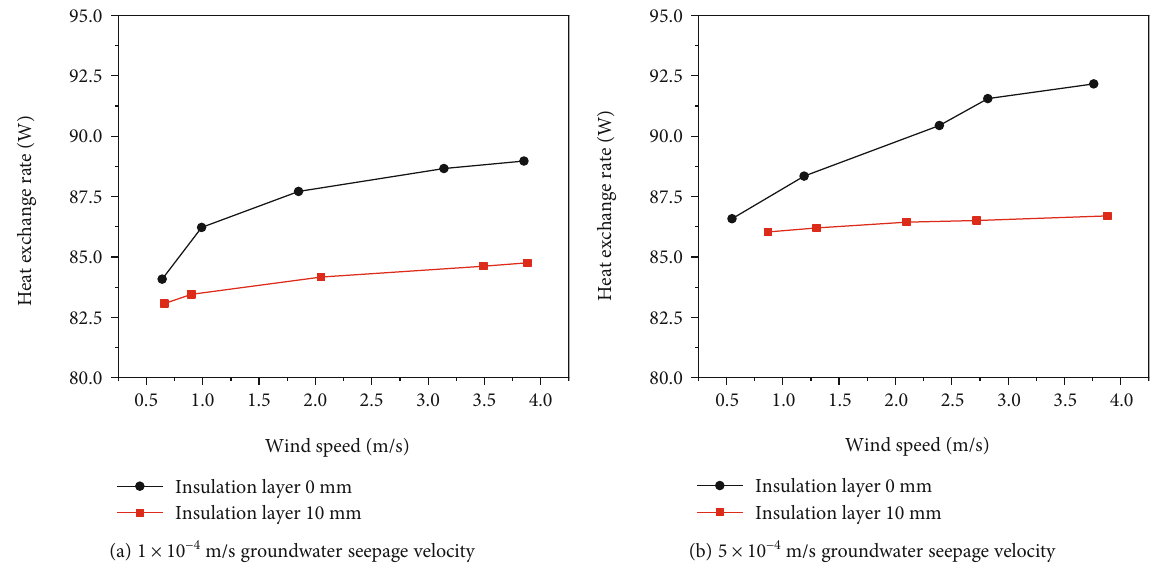
Figure 12: In fl uence of the insulation layer on the heat exchange rate of energy tunnel GHEs at di ff erent environmental